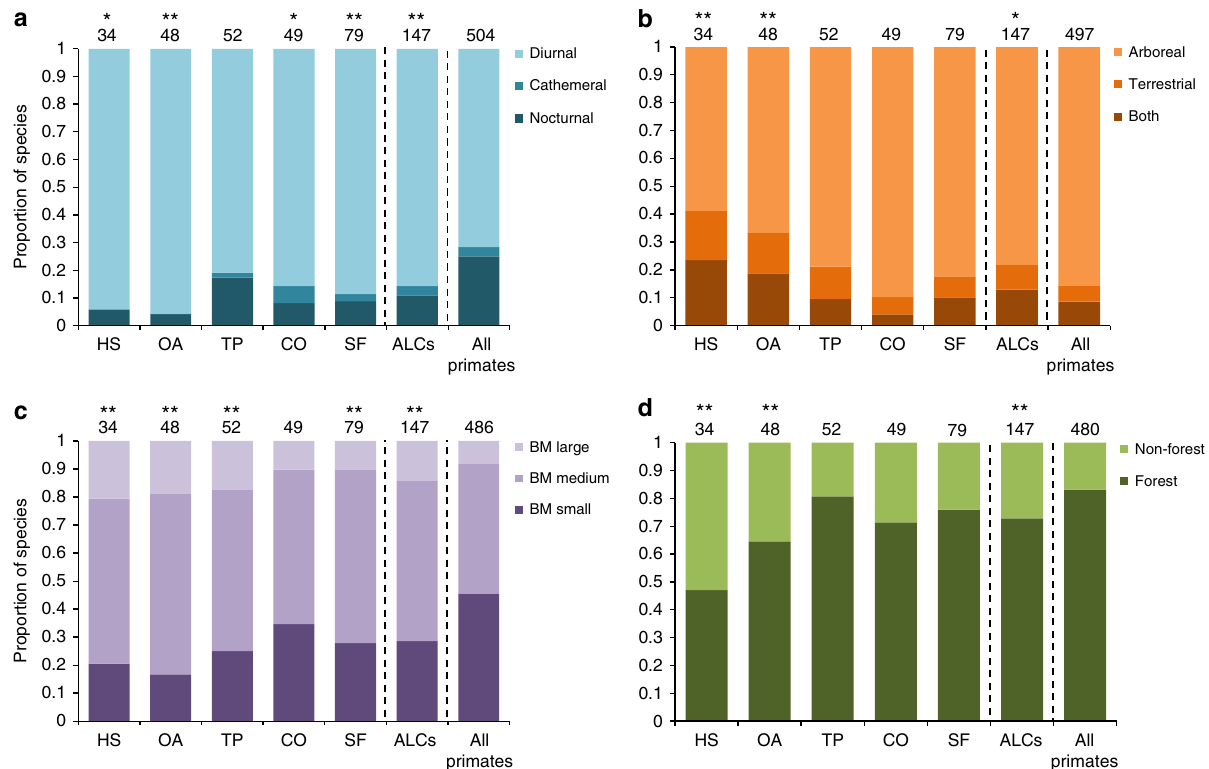
Fig. 4 Ecological traits of primate species that have been recorded using anthropic land covers (ALCs). The proportions (and total number above bars) of primate species exhibiting different diel activity patterns ( a ), modes of locomotion ( b ), body mass classes ( c ), and forest specialization or not ( d ). We tested for differences in frequencies with chi-square tests of goodness of fi t ( * P ≤ 0.05, ** P ≤ 0.01) between primates using ALCs and all the world ’ s primates, by separately assessing primate species that used different ALC types (HS human settlements, OA open areas, TP tree plantations, CO connectors, SF secondary forest). Body mass (BM) was classi fi ed as small (<2 kg), medium (2 – 10 kg), or large (>10 kg). We excluded from analyses